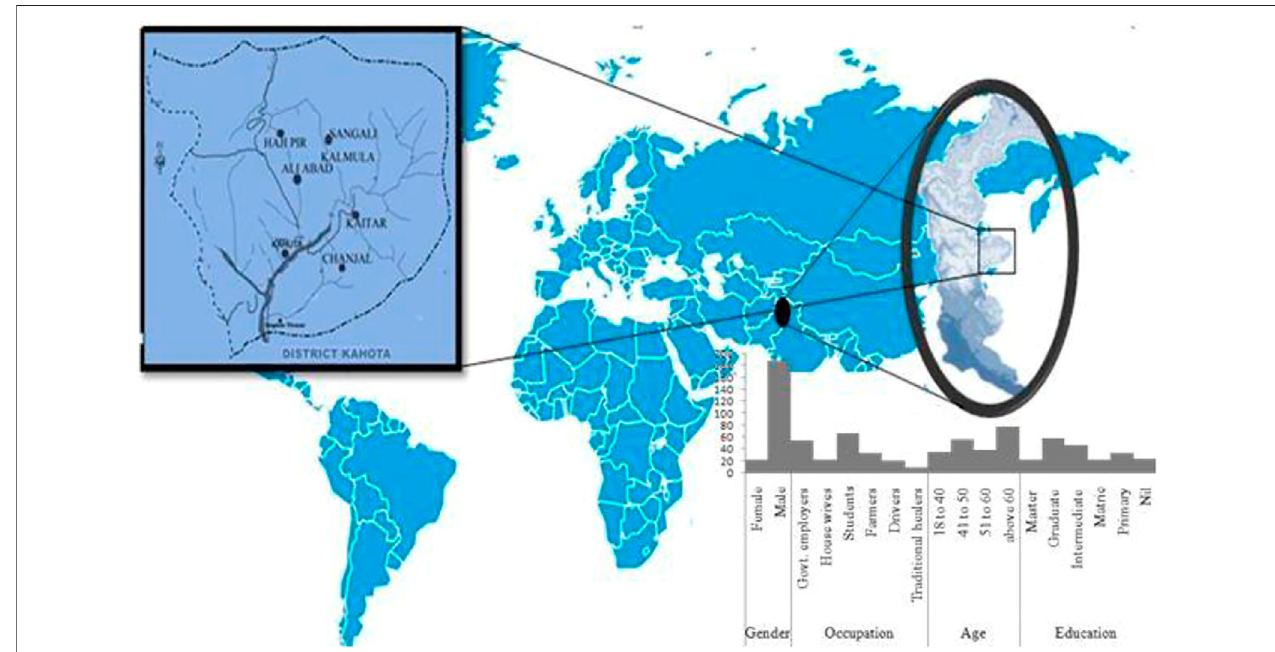
FIGURE 1 | Map and respondent pro fi le of the study area of the district